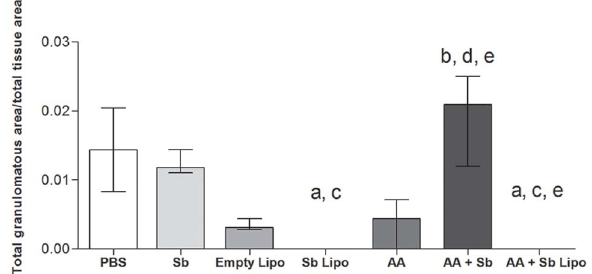
Figure 4. Quantification of granulomatous tissue in the liver of L. infantum infected mice submitted to treatment regimens. (PBS) phosphate-buffered saline, (Sb) trivalent antimony, (Empty Lipo) empty liposomes, (Sb Lipo) antimony entrapped liposomes, (AA) ascorbic acid, (AA + Sb) ascorbic acid in association with antimony, (AA + Sb Lipo) ascorbic acid in association with antimony entrapped liposomes. Y axis represents the ratio obtained by dividing the total area occupied by granulomatous tissue ( m m 2 ) by the total area of liver tissue ( m m 2 ) for each individual slide (n=3, per experimental group). Results are represented as median 6 interquartile range. Statistically significant differences were assumed when p , 0,05 in relation to (a) PBS; (b) Sb; (c) Empty Lipo; (d) Sb Lipo; (e) AA; (f) AA +